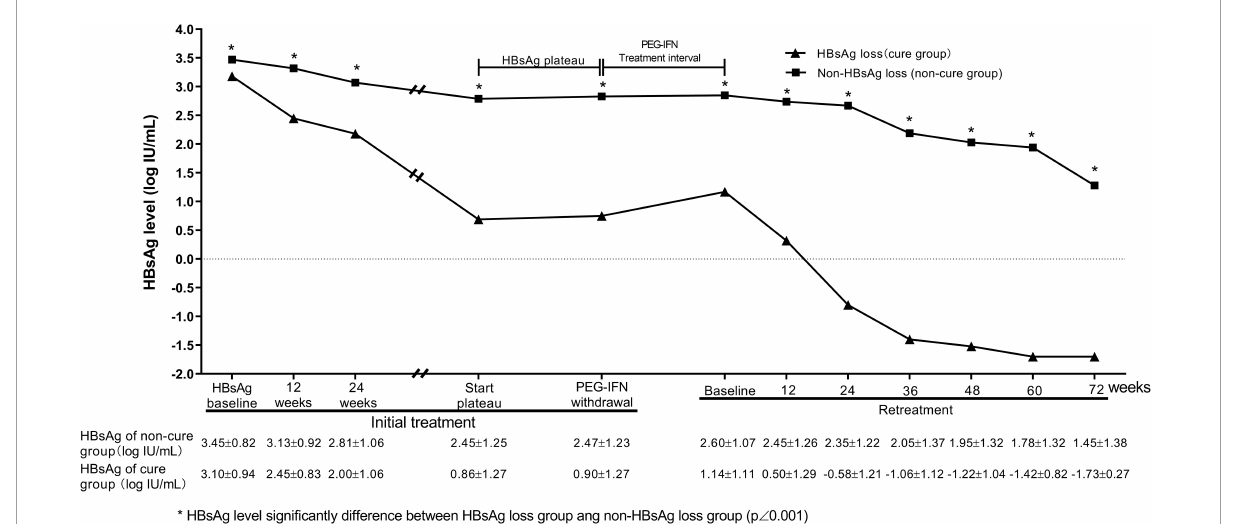
FIGURE3 Dynamic changes of HBsAg levels during treatment. There was HBsAg plateau in groups of patients with and without HBsAg loss. Compared with non-HBsAg loss group, HBsAg loss group had a rapid HBsAg decrease at early treatment in the initial and retreatment of PEG-IFN α